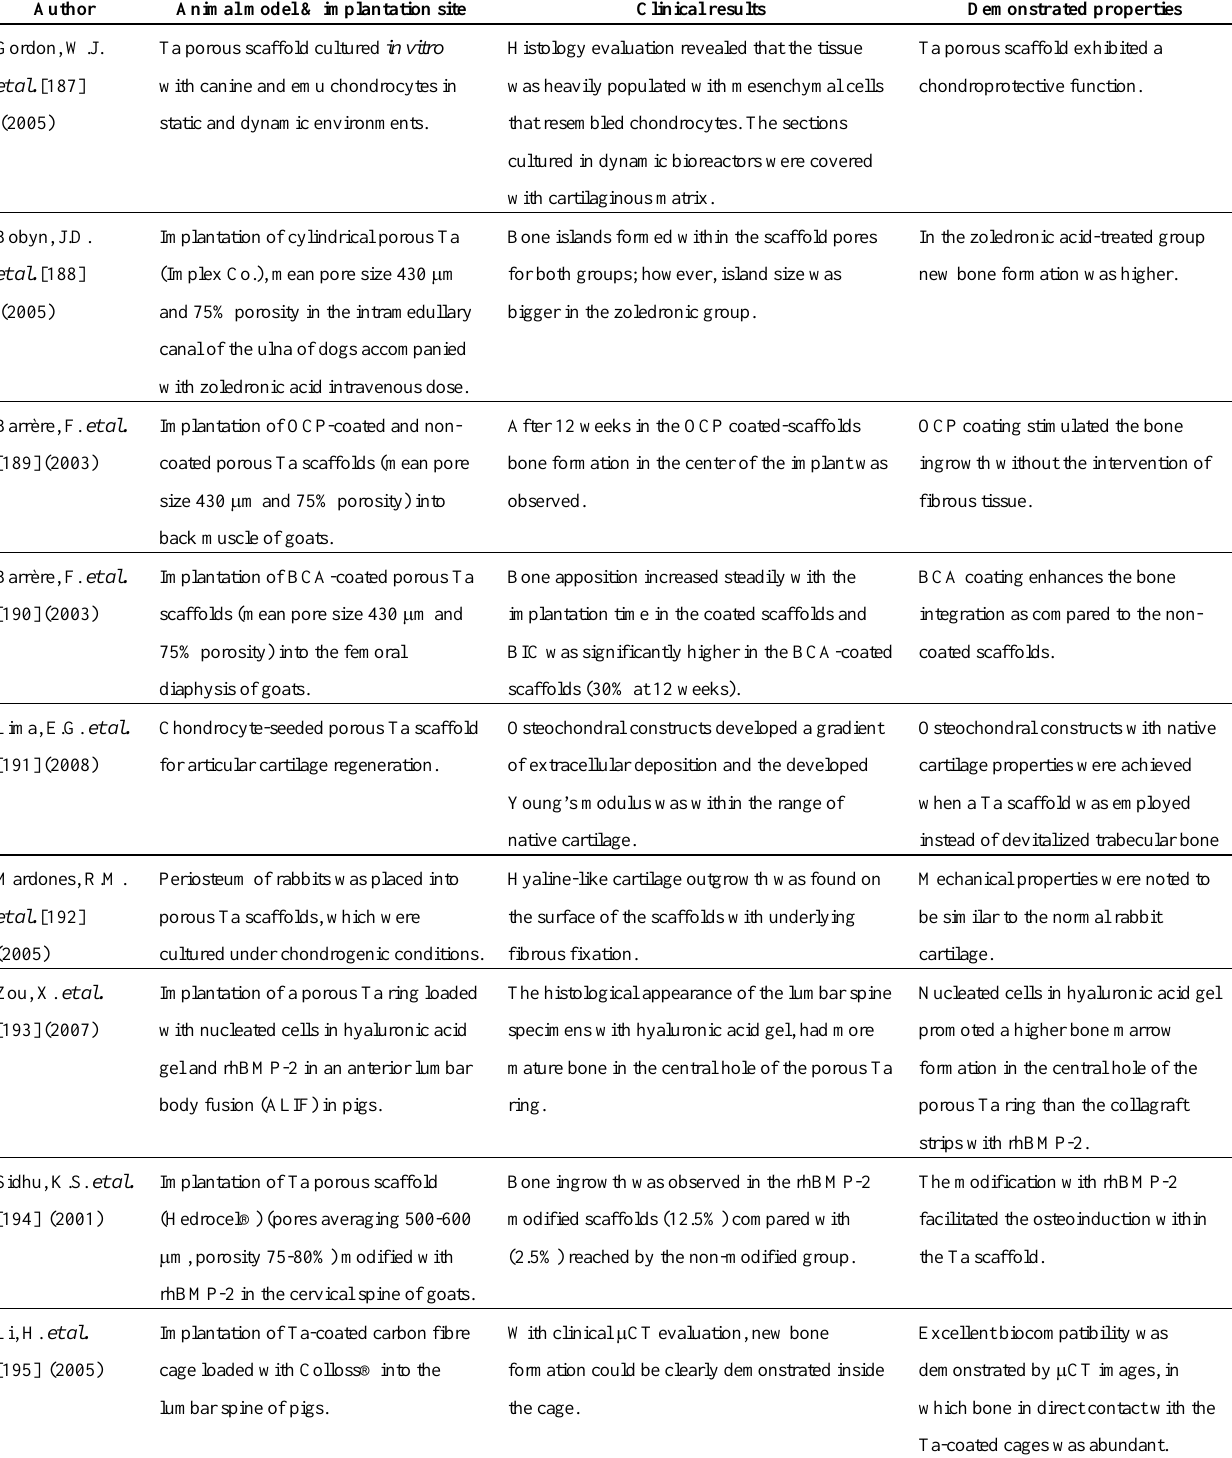
Table 14. Preclinical studies using Ta-hybrids